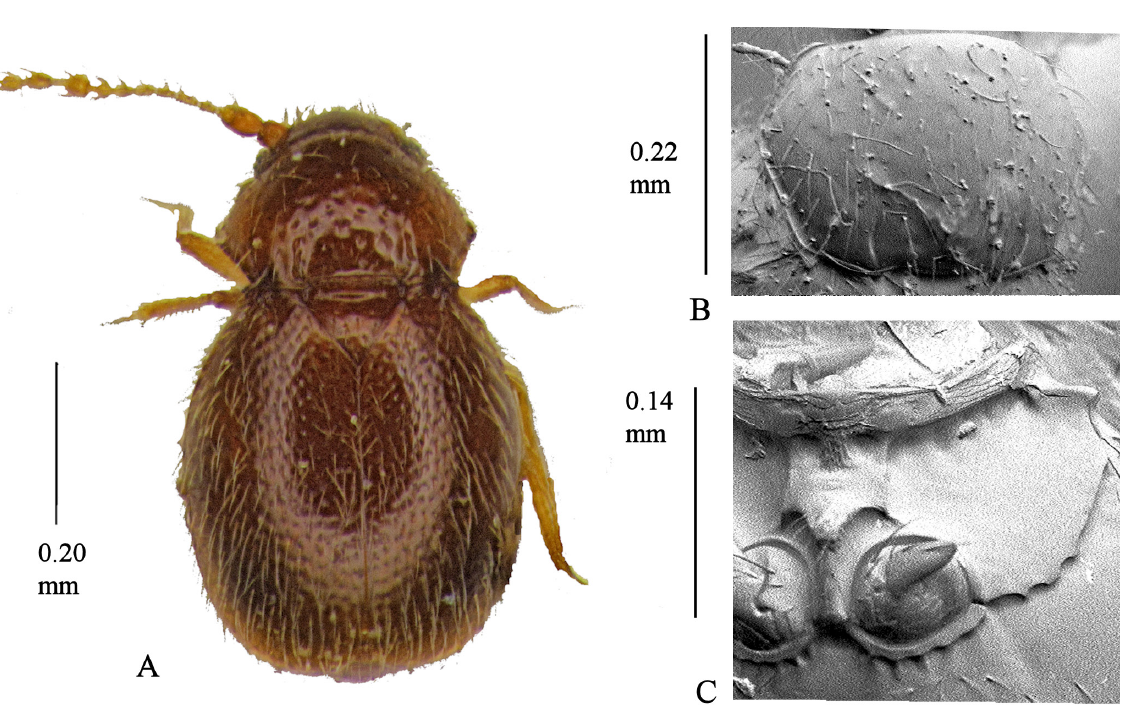
Fig. 103 . Cissidium shibatai Sawada, 2008. A . Habitus. B . Pronotum, × 470. C . Mesoventrite showing median process of collar, mid-keel, keel and lateral margin, × 465. Meso-and metaventrite copied from Sawada